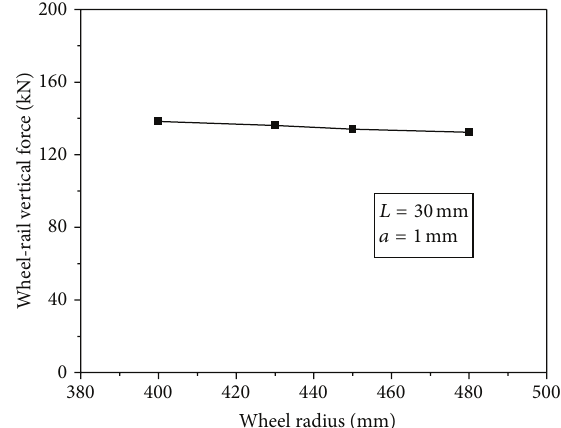
Figure 12: Wheel-rail vertical force versus wheel radius.